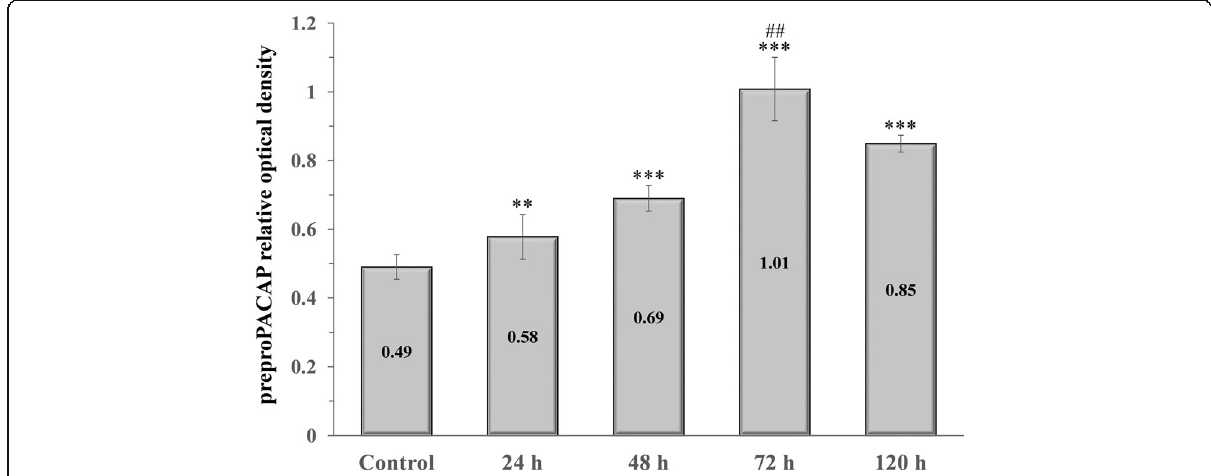
Fig. 1 Relative optical density of the preproPACAP protein in the TNC following orofacial CFA treatment. *** p <0.001 vs. Control group, ** p <0.01 vs.